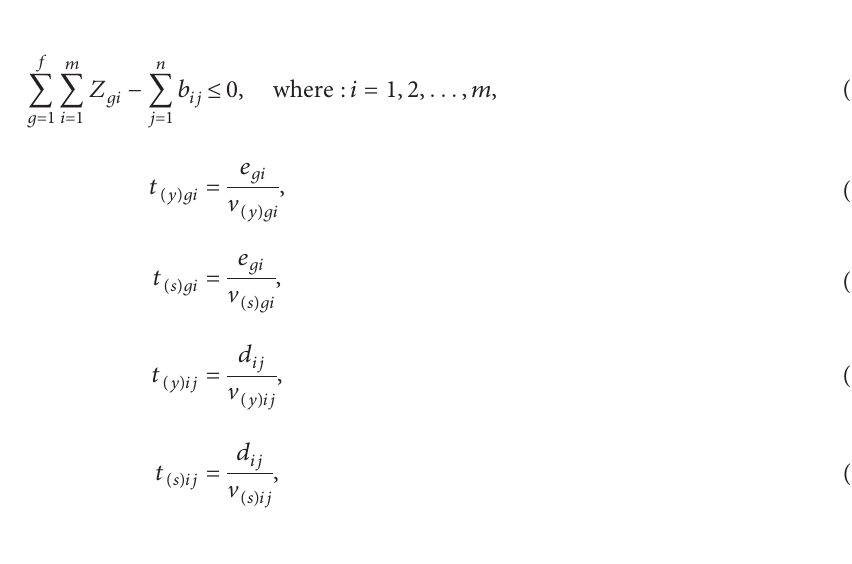
Figure 3: Topology diagram of supplier-distribution centers-customer